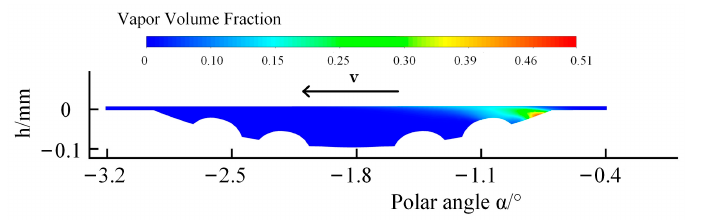
Figure 11. Vapor volume fraction contour of the circumferential profile of a Single circular pit with a radius of R 2 = 32 mm.